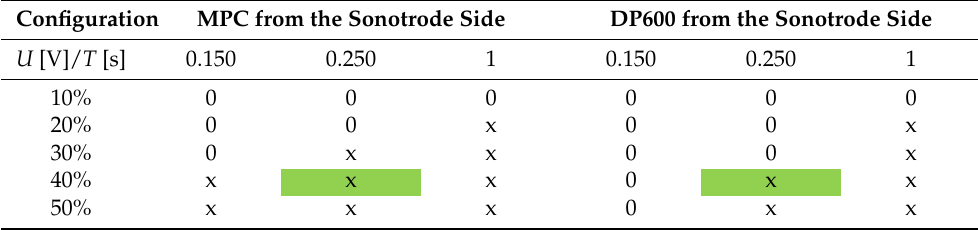
Figure 14. The illustration of: ( A ) UT + RSW process and ( B ) the example of welded joints of Litecor with DP600. Table 5. The selection of the ultrasonic heating parameters.